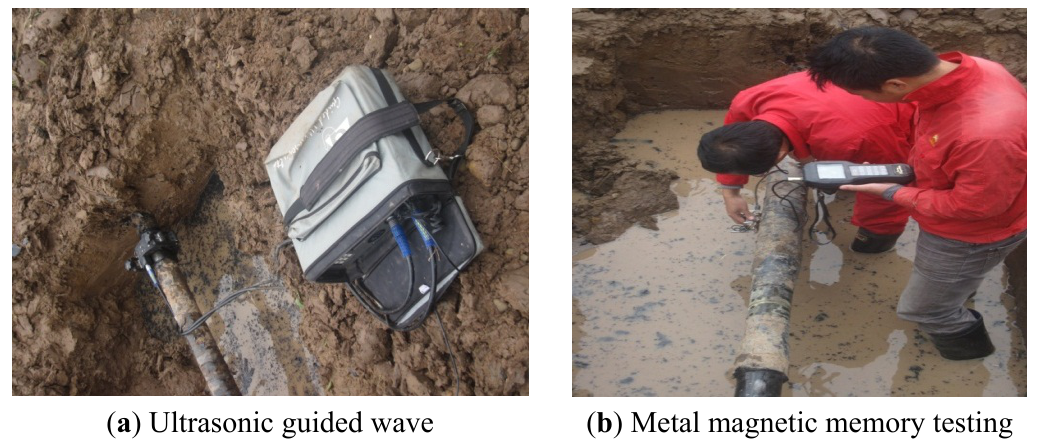
Figure 5. The excavation points of the validation pipeline.